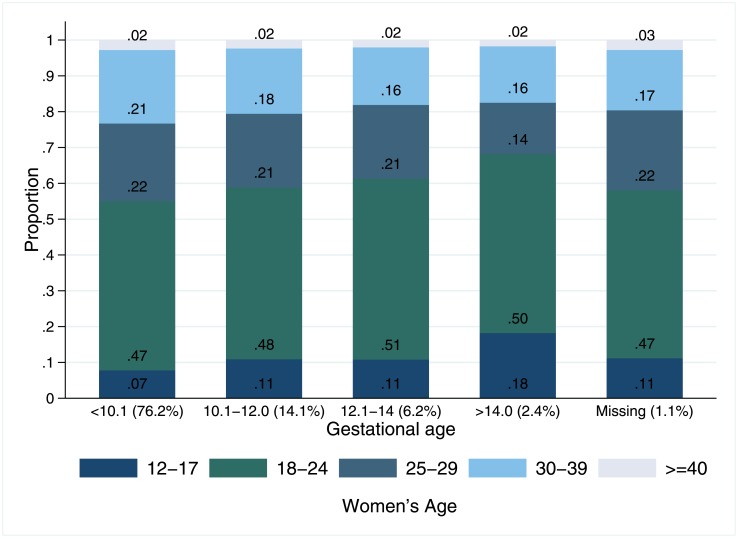
Distribution of age of the women seeking legal abortion services al ILE program, by gestational age.Note: Proportion of the sample in each gestational age group in parenthesis, Chi square test by age group *p<0.05. 1.10% (n = 560) of the sample did not have gestational age information, 60.01% did not receive an abortion due to presenting past the GA limit.